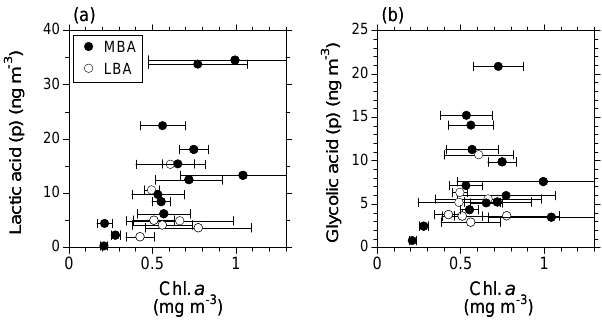
Figure 3. Concentrations of (a) lactic and (b) glycolic acids in the particulate phase as a function of Chl a concentrations in seawater for more biologically influenced aerosols (MBAs) and less biologi- cally influenced aerosols